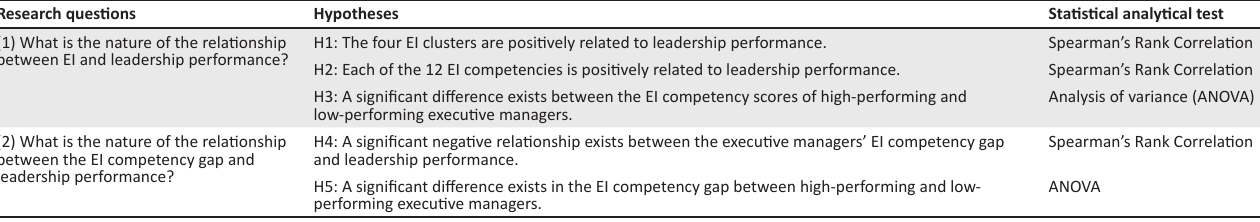
TABLE 2: The study’s research questions, hypotheses and analytical tests.